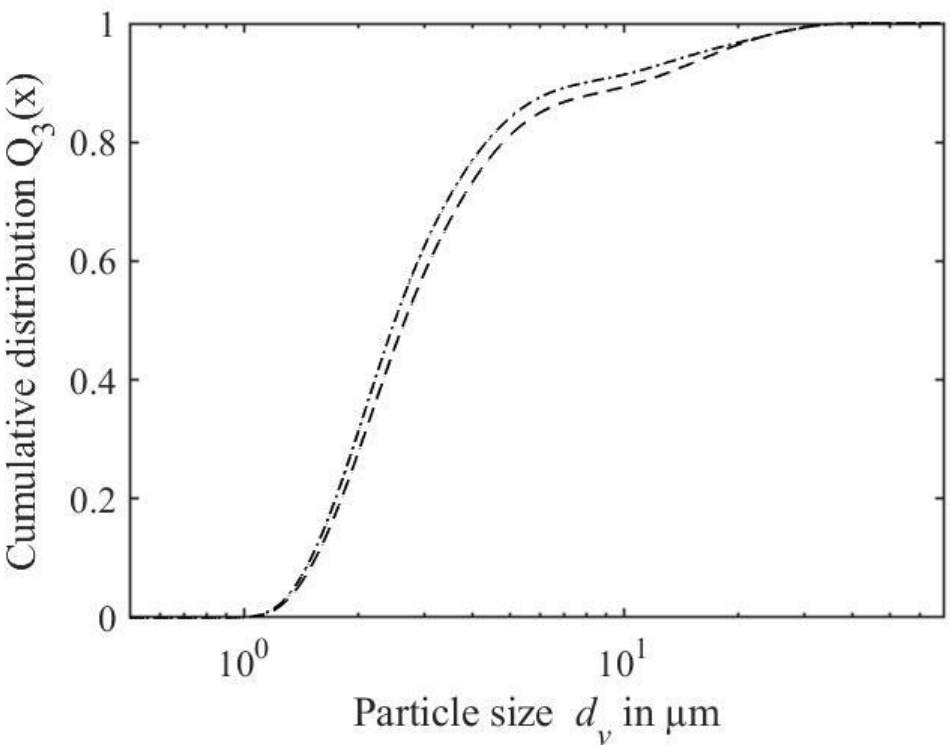
Figure 4. Particle size distributions of whey protein pectin complexes prepared using WPI nzmp and pectin as separate stock solutions (5% protein, 1% pectin) with hydration (method A, solid line) and without hydration (method B, dotted line) after mixing.